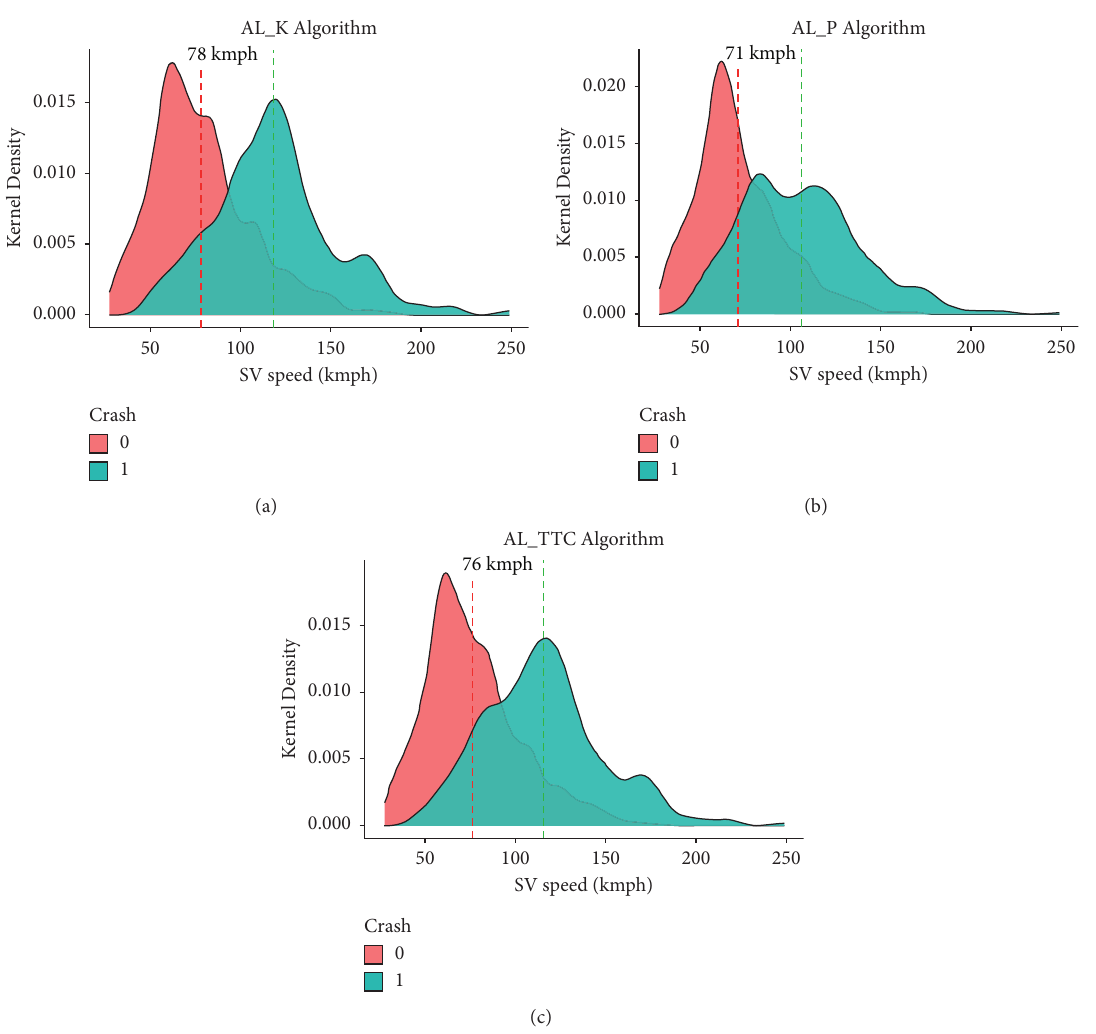
Figure 6: The kernel density estimate of subject vehicle’s speed based on AEB activation for different algorithms (the effectiveness of different AEB algorithms based on subject vehicle’s speed). (a) AL_K algorithm. (b) AL_P algorithm. (c) AL_TTC algorithm.